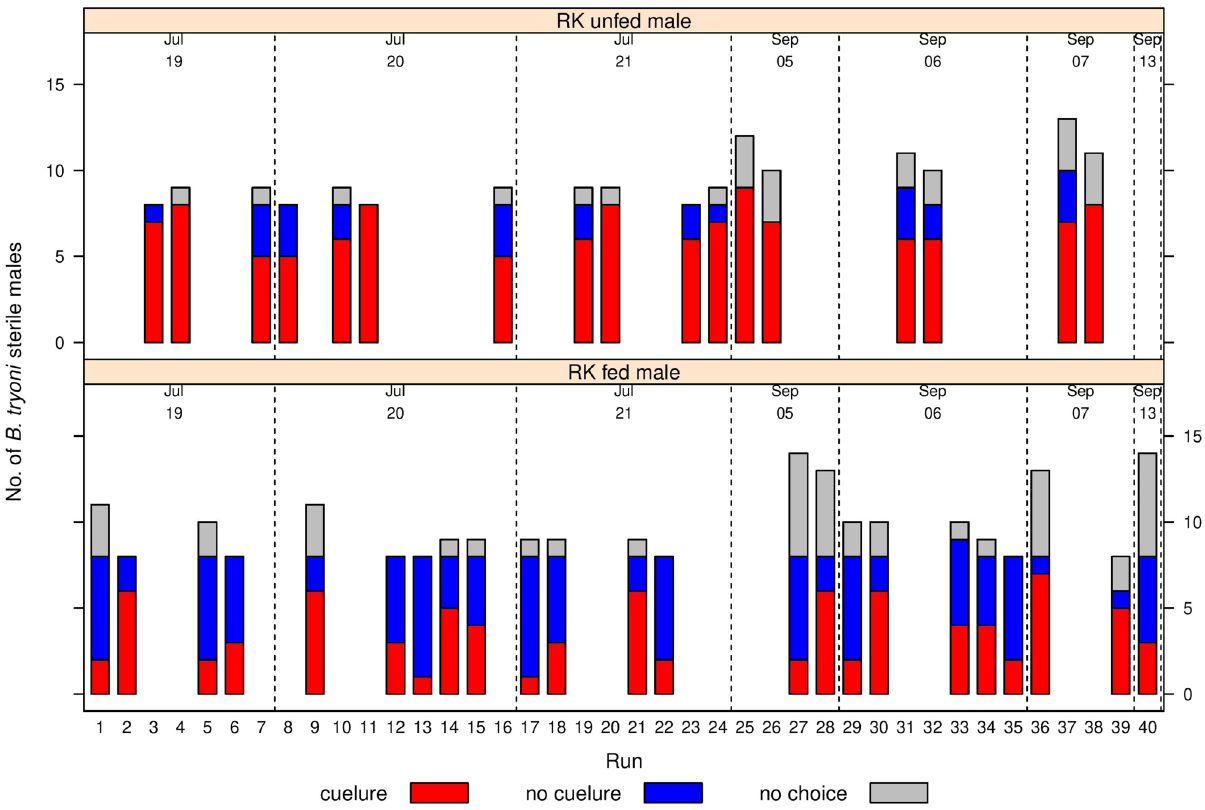
Figure 1. Y-tube olfactometer raw choice data for sterile male B. tryoni that were RK-unfed (top) or RK-fed (bottom) across 40 runs. Each bar shows the number of males selecting cuelure (red), no cuelure (blue) or no choice (grey). The trials were all run in 2018, with the date of each run shown above the bars, separated by vertical dotted lines.